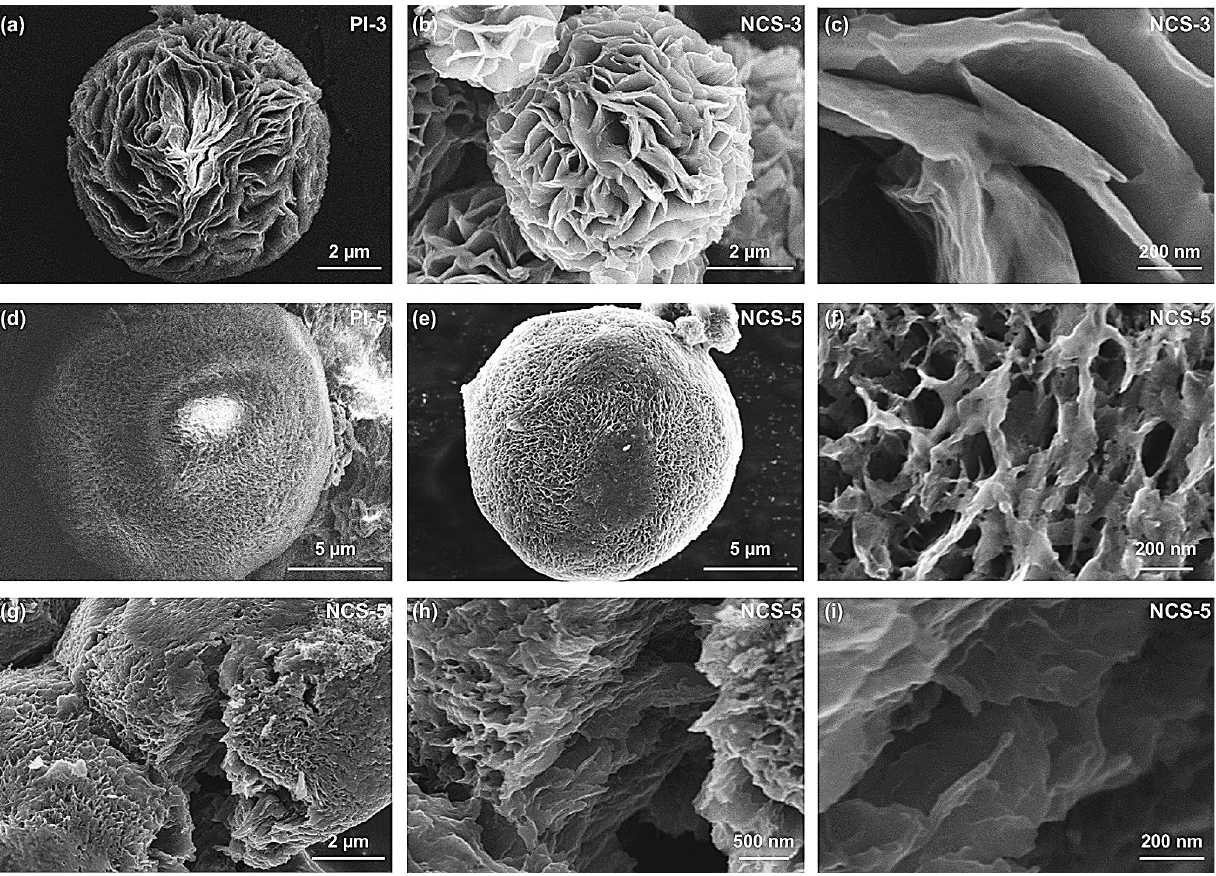
Fig. 2 SEM images of ( a ) PI-3, ( b, c ) NCS-3, ( d ) PI-5, and ( e, f ) NCS-5 at different magnifications. ( g–i ) Cross-sectional SEM images of NCS-5 at different